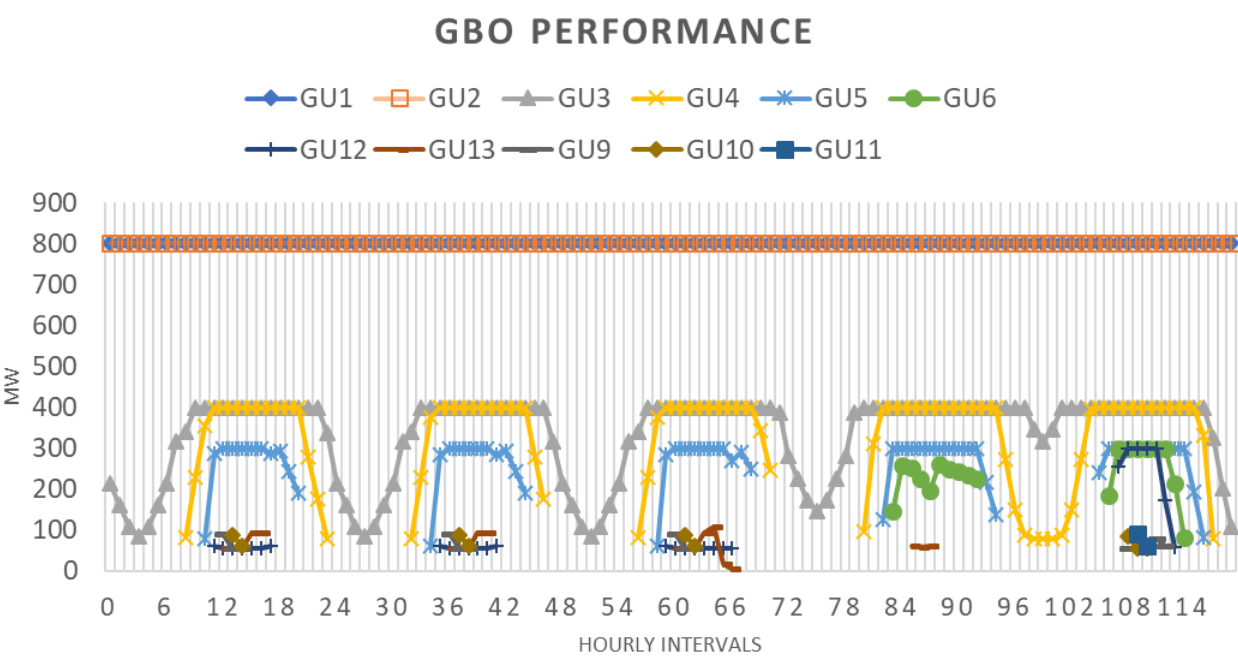
Figure 4. Performance of the gradient-based optimization pertaining to the five-day paradigm. With respect to genetic algorithms, the available function GA in the MATLAB optimization toolbox was taken into account, considering two coupling constraints and mixed-integer limitations. The drawback of the developed algorithm lies in the increased number of function evaluations (showing an exponential increase compared with LR) and the violation of coupling constraints. As a result, a penalty cost for the P ENS and P SRNS retrieved as 𝑎̂ = 𝑚𝑎𝑥 𝑎 𝑖 , 𝑏̂ = 𝑚𝑎𝑥 𝑏 𝑖 , 𝑐̂ = 𝑚𝑎𝑥 𝑐 𝑖 was considered, resulting in a final TPC of 2,378.296 k$. The power deficits can be seen in Figure 5.